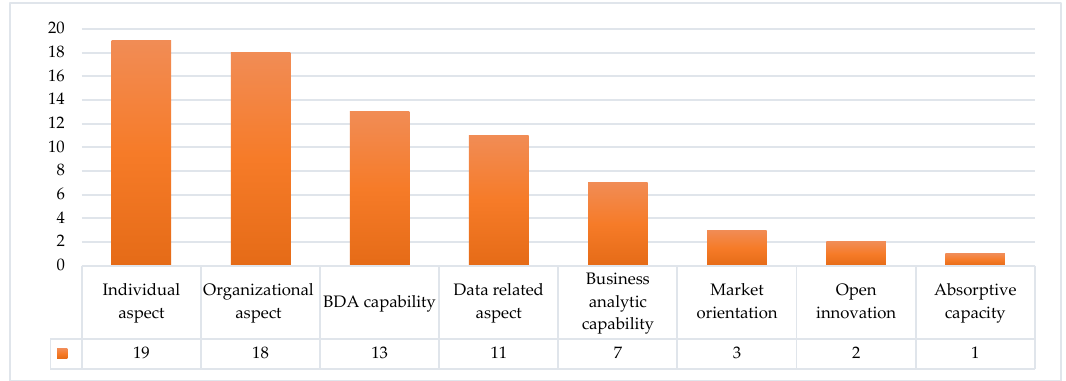
Figure 9. Factors leading to the successful use of big data analytics and improvement of firm performance .